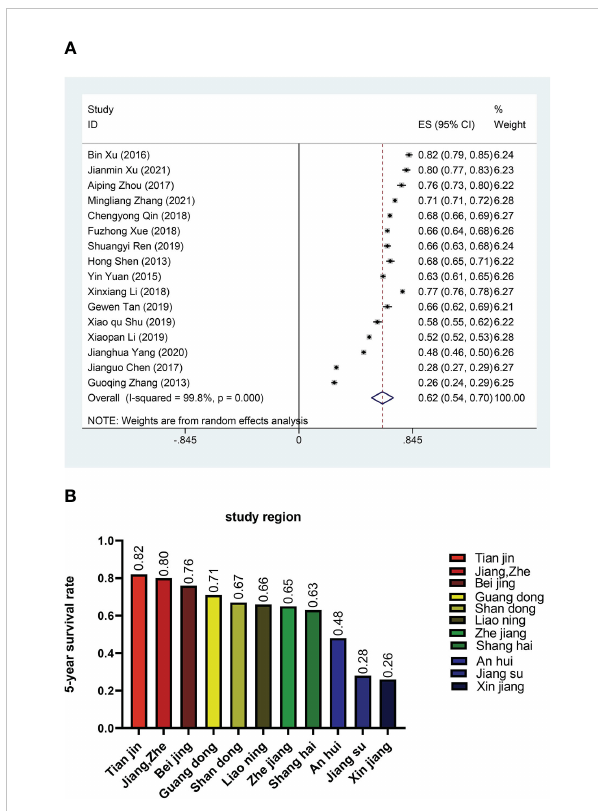
FIGURE 3 Survival rates in different regions (A) Forest plot of survival rates in different regions. (B) Histogram of survival rates in different